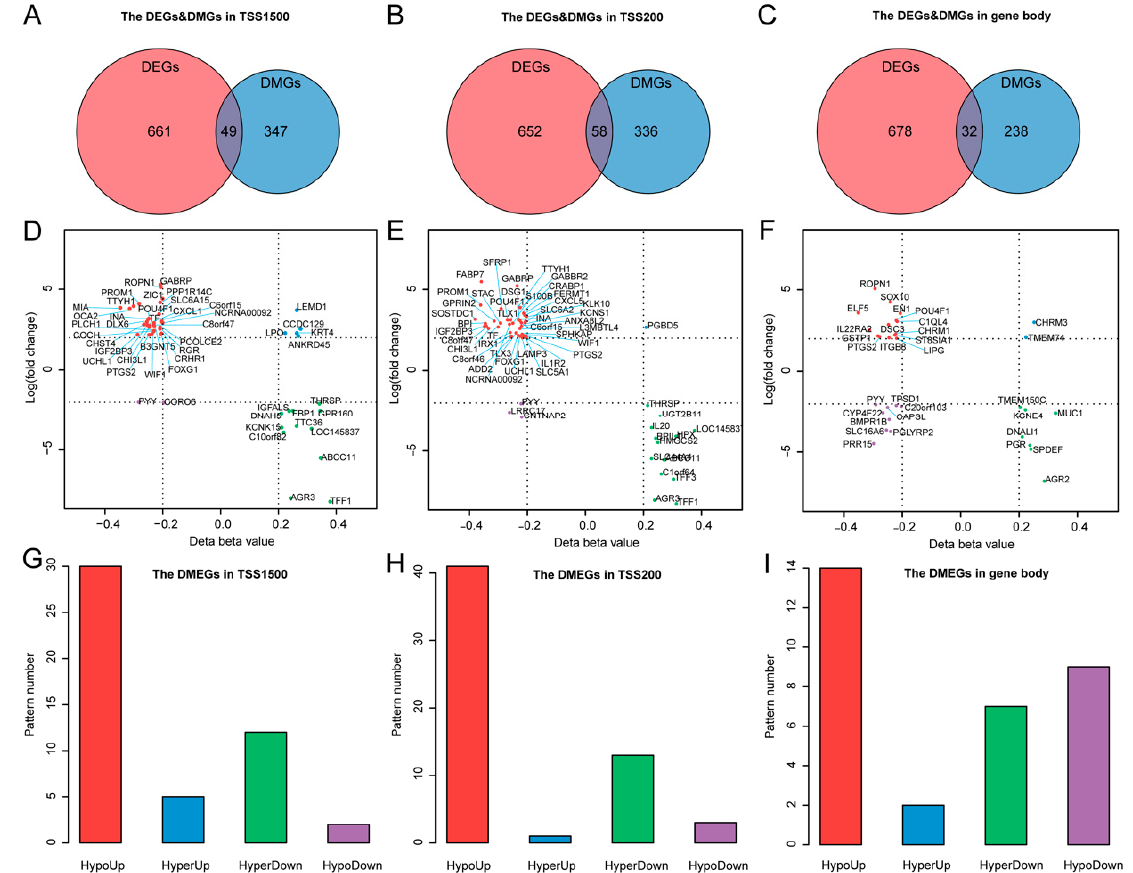
Figure 3. Di ff erentially methylated and expressed genes (DMEGs) in TNBC. ( A – C ) Venn plots showing the DMEGs between DMGs and DEGs in TSS1500, TSS200, and gene body regions. ( D – F ) Quadrant plot showing DNA methylation and gene expression of DMEGs in TSS1500, TSS200, and gene body regions. The x -axis represents delta of mean methylation level ( β -value) of all 5’-C-phosphate-G-3’ (CpG) cites with ≥ 20% di ff erence in methylation for each gene between TNBC and TPBC. The y -axis represents log2-transformed fold change of gene expression between TNBC and TPBC. Vertical dashed lines indicate the threshold of 20% methylation di ff erence, and horizontal dashed lines indicate the threshold corresponding to 2-logFC gene expression change. The four quadrants represent four methylation and expression patterns in TNBC: HypoUp, HyperUp, HyperDown, and HypoDown (see text for details). ( G – I ) Bar plots showing the number of four regulation patterns between methylation and expression of TNBC in three regions.